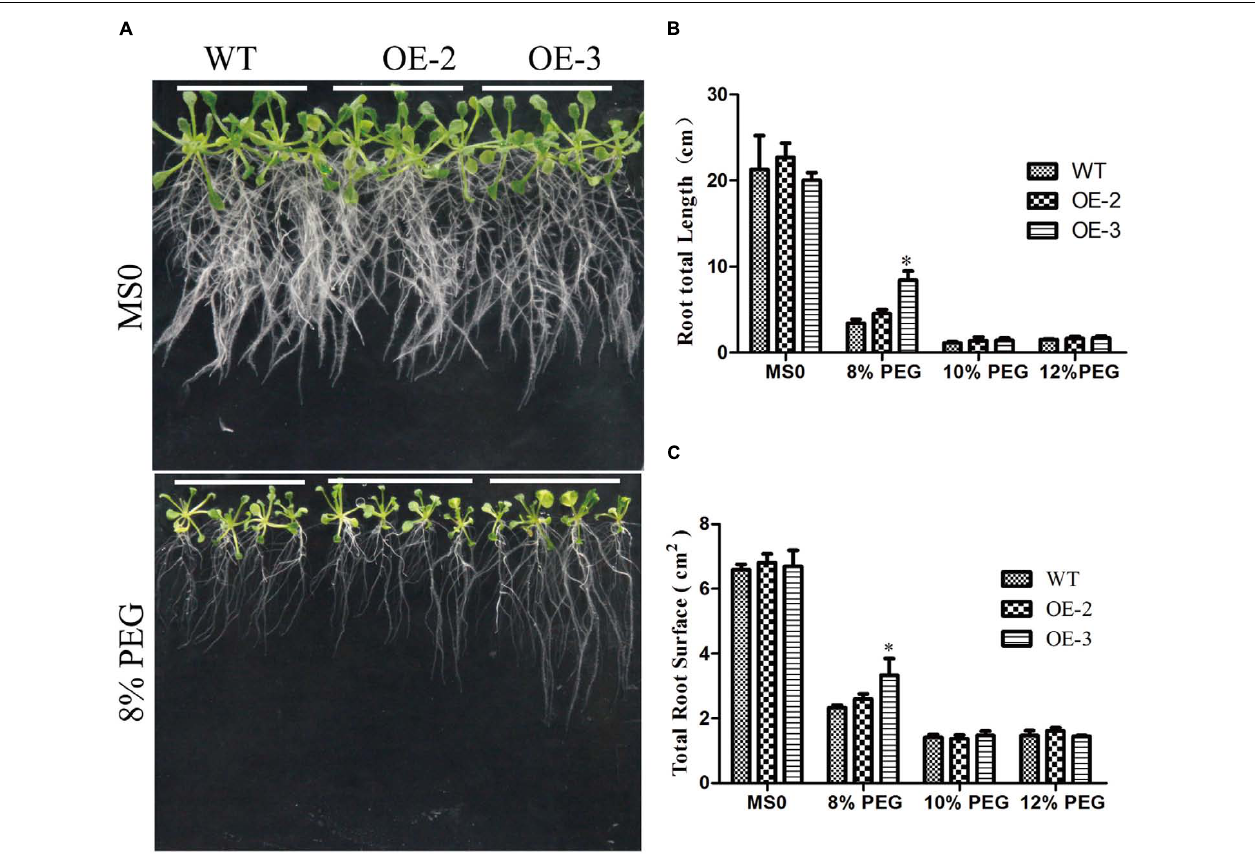
FIGURE 12 | Phenotypic comparison under PEG treatment. (A) Phenotypic comparison. Seedlings grown on 1/2 medium for 4 days were transferred to 1/2 medium with or without PEG. (B) Comparative root lengths of WT and transgenic lines. (C) Total root surface of WT and transgenic lines. Mean values and standard errors were shown from three independent experiments ( n = 27). Independent t -tests demonstrated that there was significant difference ( ∗ P < 0.05) between the transgenic lines and